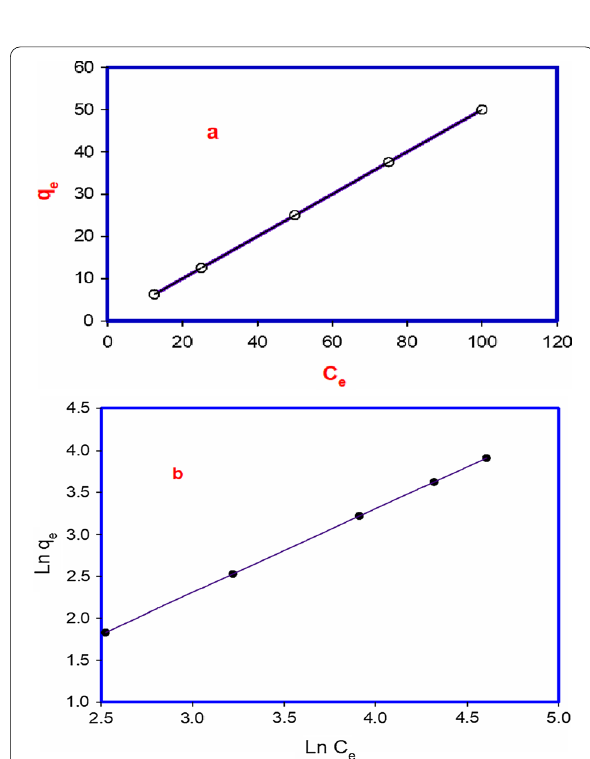
Fig. 11 a Langmuir and b Freundlich isotherms of the adsorption of C.V on